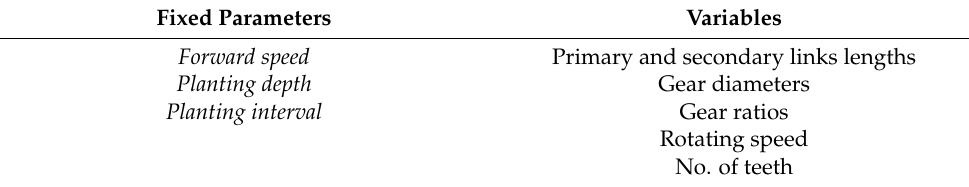
Table 3. Simulation parameters for the planting mechanism.